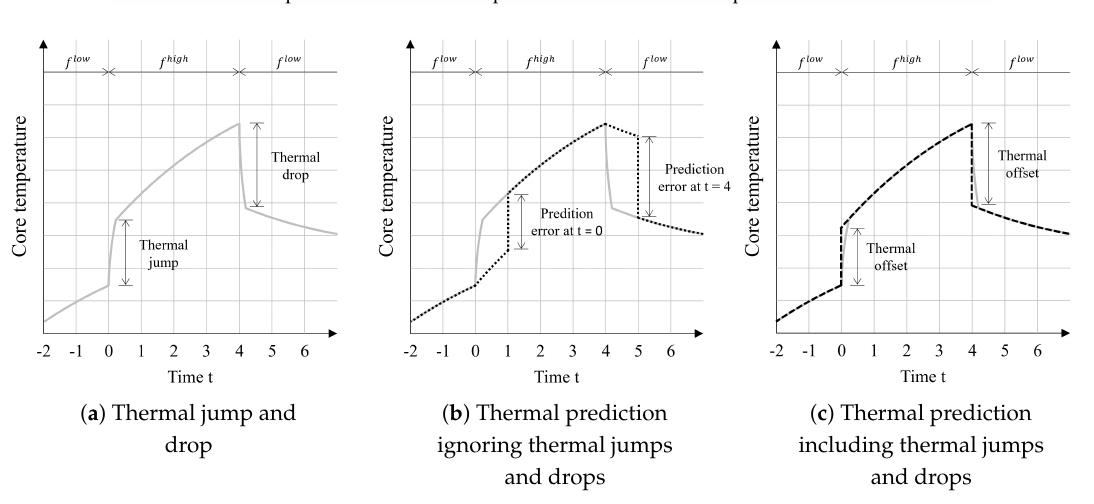
Figure 9. Modeling of thermal jumps and